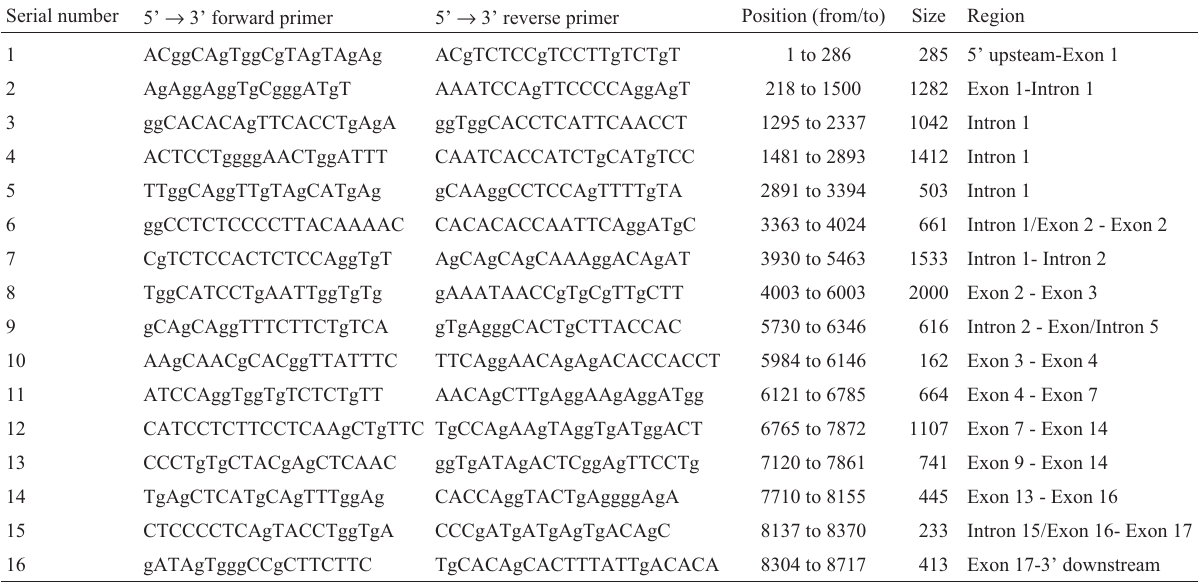
Table 1 - Primer pairs for amplification of the Indian buffalo ( Bubalus bubalis ) DGAT1 gene. Serial number 5’ → 3’ forward primer